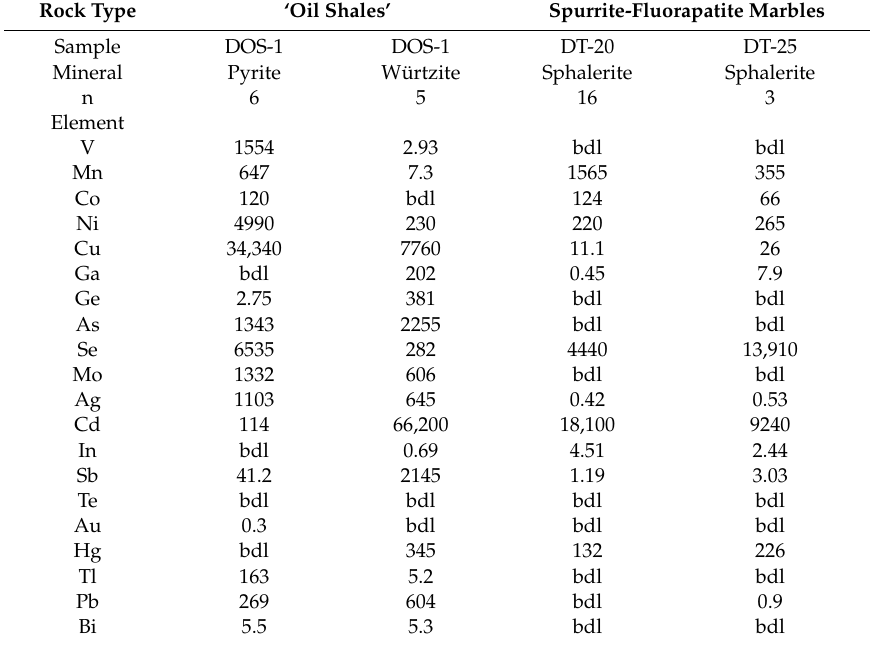
Table 3. Average trace-element composition (ppm) of sphalerite from spurrite-fluorapatite marbles (Tulul al Hammam area), compared with Fe- and Zn sulfides from ‘oil shales’ (Muwaqqar Chalk Marl Formation). LA-ICPMS